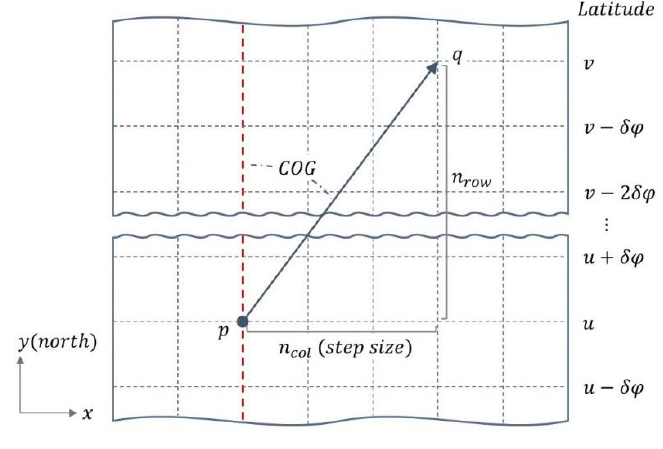
Figure 4. Calculation of COG.